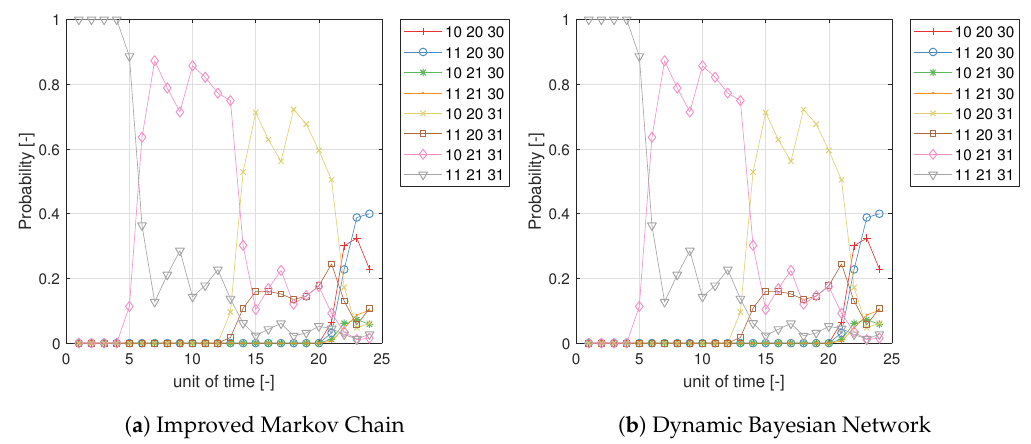
Figure 8. Network State Probability: Two critical lines with the wind spatial profile